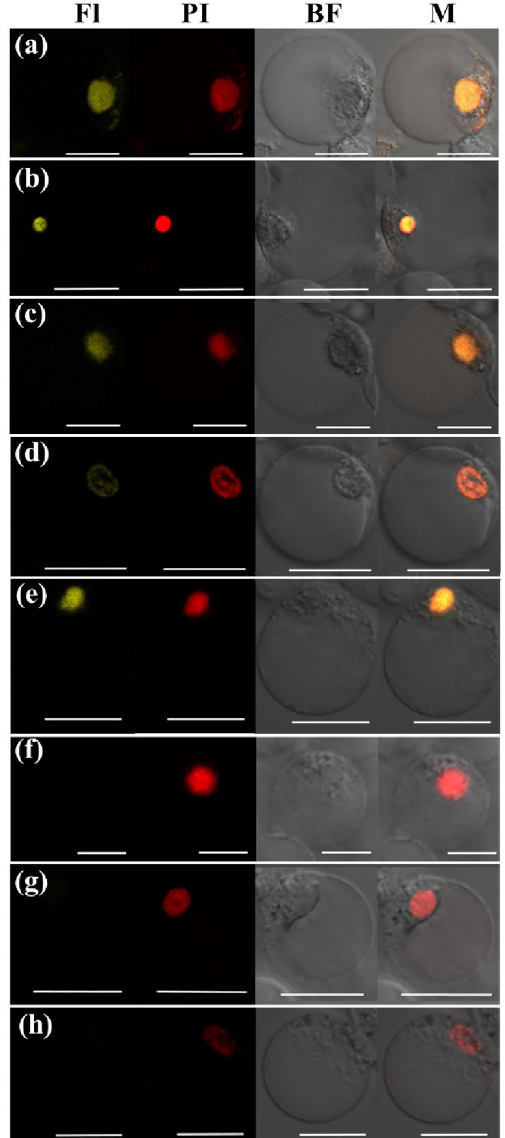
Figure 5. Analysis of protein–protein interactions among B sister PeMADS28, C-class PeMADS1, D-class PeMADS7 and E-class PeSEP3 proteins by BiFC method. Fusion proteins were expressed in Phlaenopsis petal protoplasts. ( a ) PeMADS28:YFPc + PeMADS28:YFPn. ( b ) PeMADS28:YFPc + PeSEP3:YFPn. ( c ) PeSEP3:YFPc + PeMADS28:YFPn. ( d ) PeMADS28:YFPc + PeMADS7:YFPn. ( e ) PeMADS7:YFPc + PeMADS28:YFPn. ( f ) PeMADS28:YFPc + PeMADS1:YFPn. ( g ) PeMADS1:YFPc + PeMADS28:YFPn. ( h ) YFPc + YFPn as a negative control. BF, bright field; Fl, fluorescence image; M, Merged image; PI, propidium iodide. Bars, 20